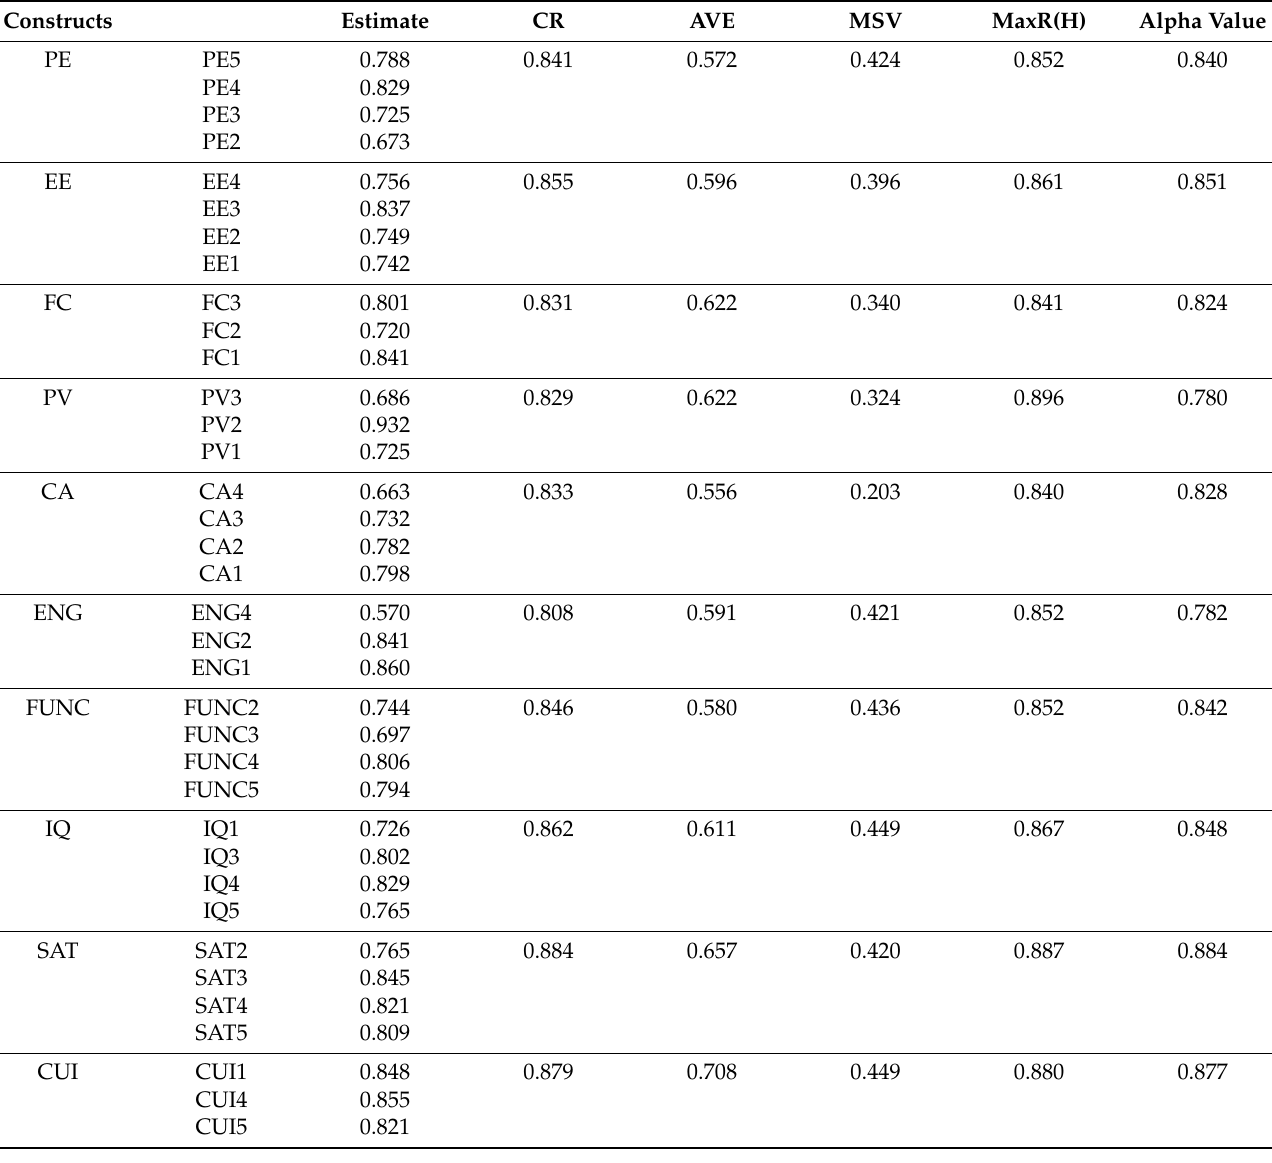
Table 3. Reliability and validity.